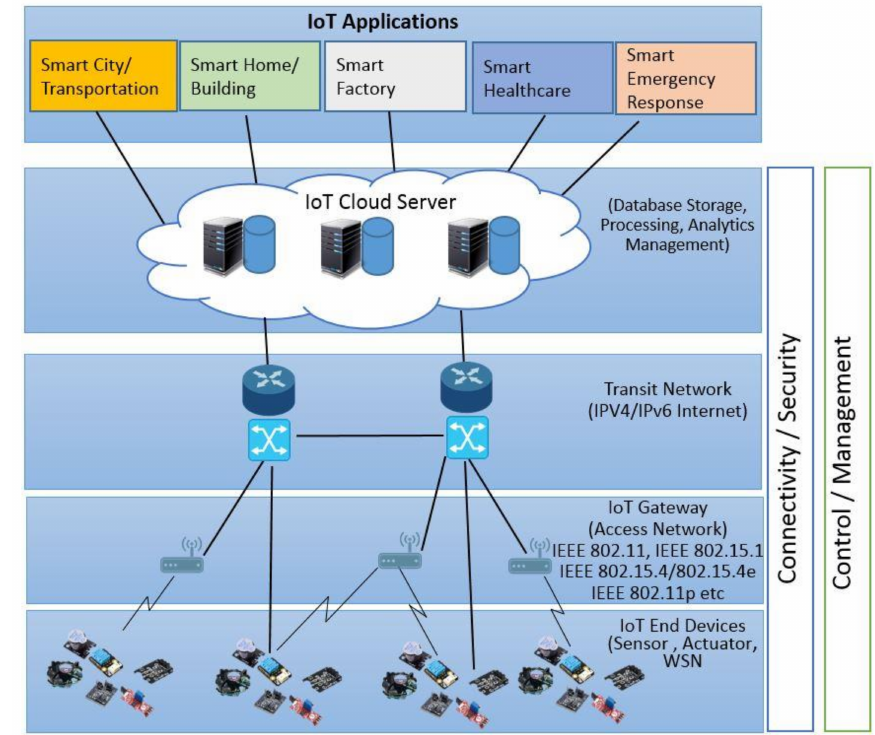
Figure 1. The conceptual view of the Internet of things